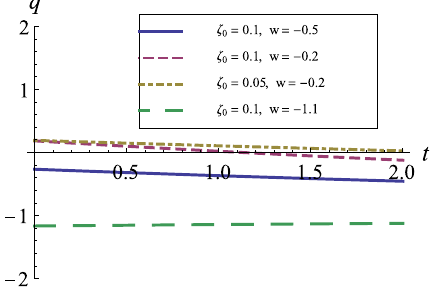
Fig. 4 The figure of deceleration parameter q against cosmic time t has been plotted for M p = 1, c = 1 and H 0 = 10